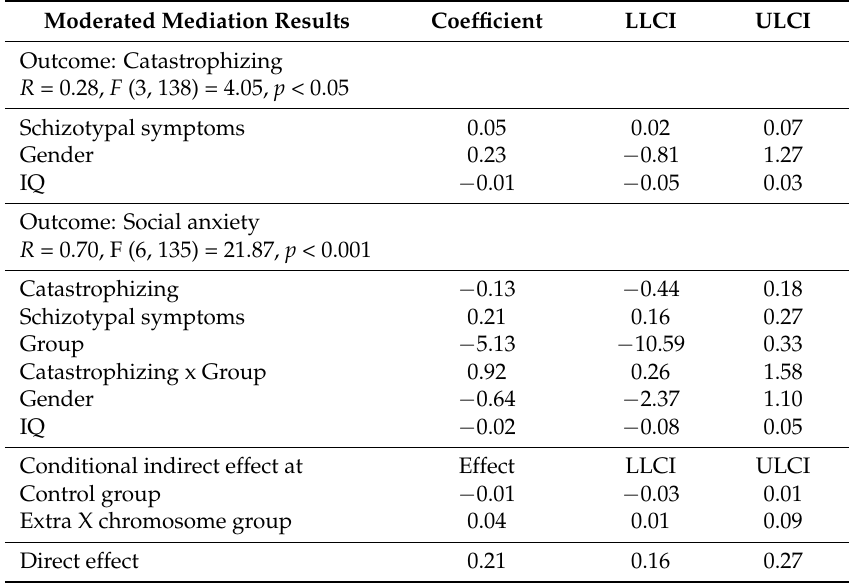
Table 3. Moderated Mediation Results for the Link between Schizotypal Symptoms and Social Anxiety with 95% Bias-corrected Confidence Intervals ( n = 142). Moderated Mediation